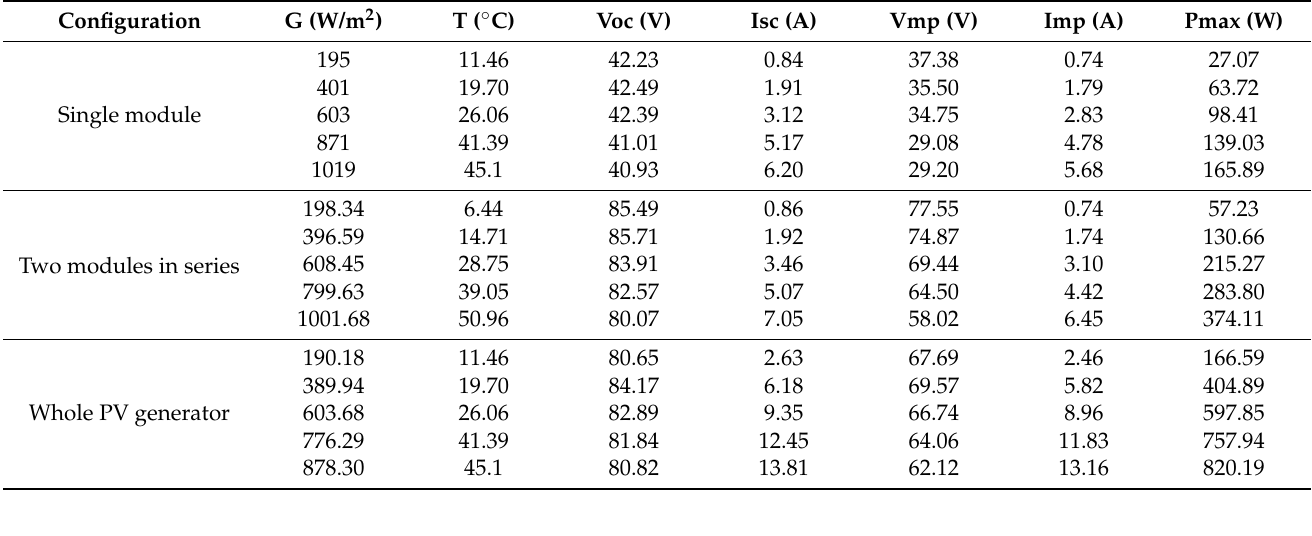
Table 4. Irradiance, temperature, and electrical parameters measured during characterization for different configurations of the PV modules.